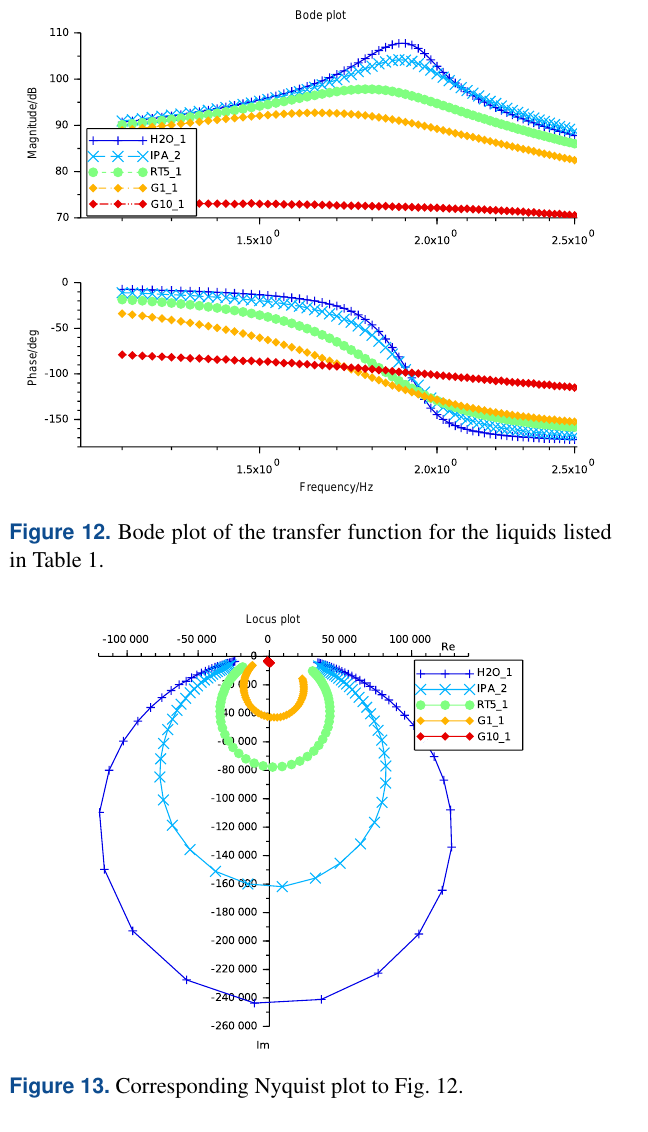
Figure 15. The ball’s orbit in water; k o = 0 . 1; f o = 0 . 2Hz; note that this is still a closed